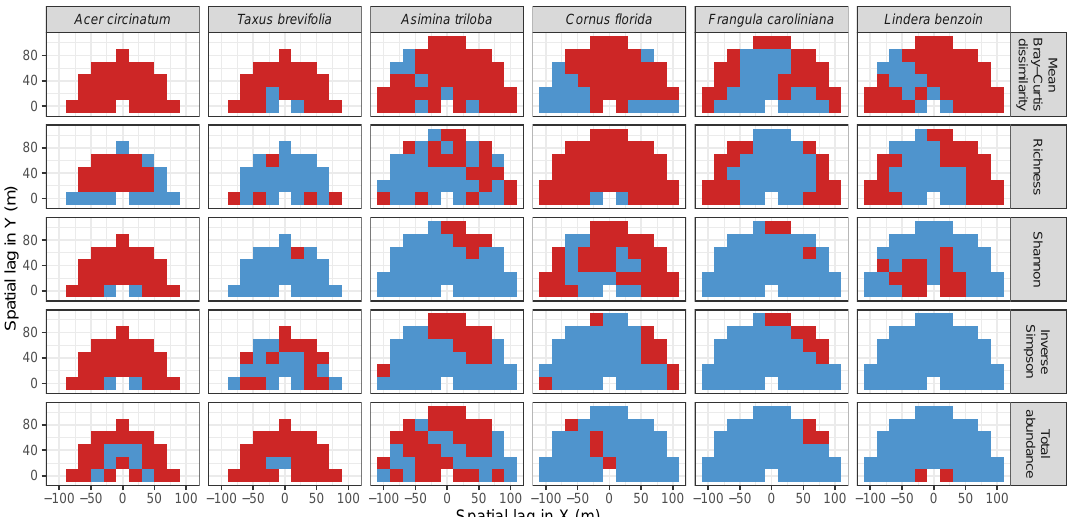
Figure A8. Statistical significance (red: P ≤ 0.05; blue: P > 0.05) of the codispersion coefficients calculated between measures of diversity and total basal area of the focal understory species in 20 20-m subplots in the 25.6-ha Wind River ( Acer circinatum, Taxus brevifolia ) and 20-ha Tyson Research Center ( Asimina triloba, Cornus florida, Frangula caroliniana, Lindera benzoin ) plots (Figure A6). Statistical significance was determined by comparing observed codispersion at each spatial lag with a distribution of 199 spatial randomizations of a CSR null model.